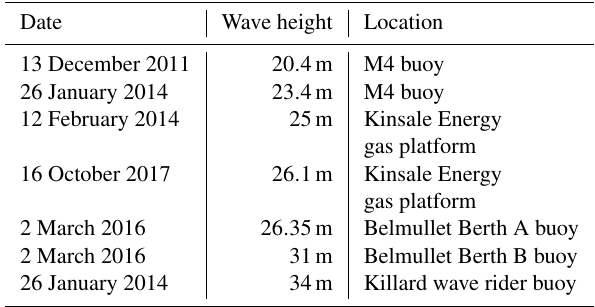
Table 7. Largest waves recorded in Irish marine